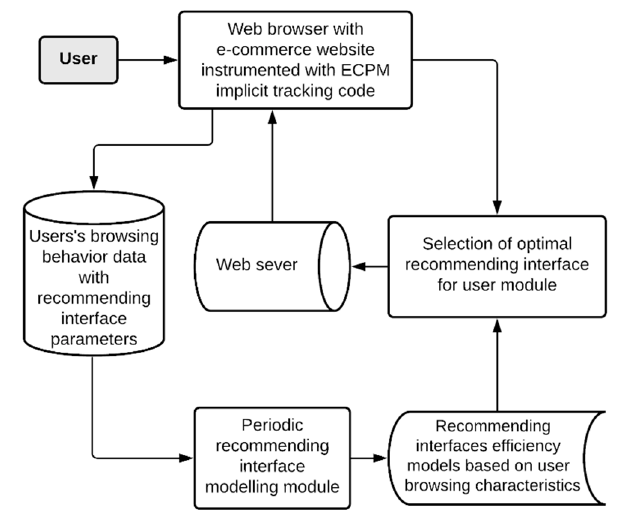
Figure 1. Conceptual system architecture.